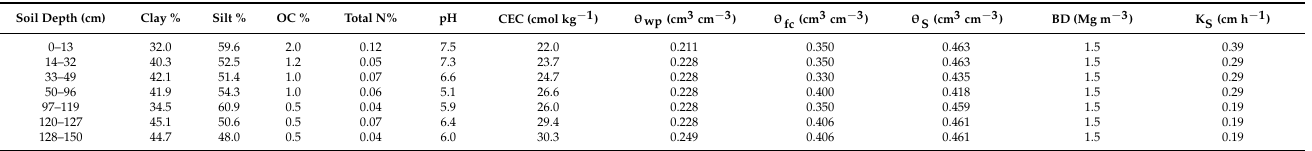
Table 1. Soil parameters for Forestdale soil series in the simulation for both growing seasons using CSM-CROPGRO-cotton and APSIM-OzCot-cotton